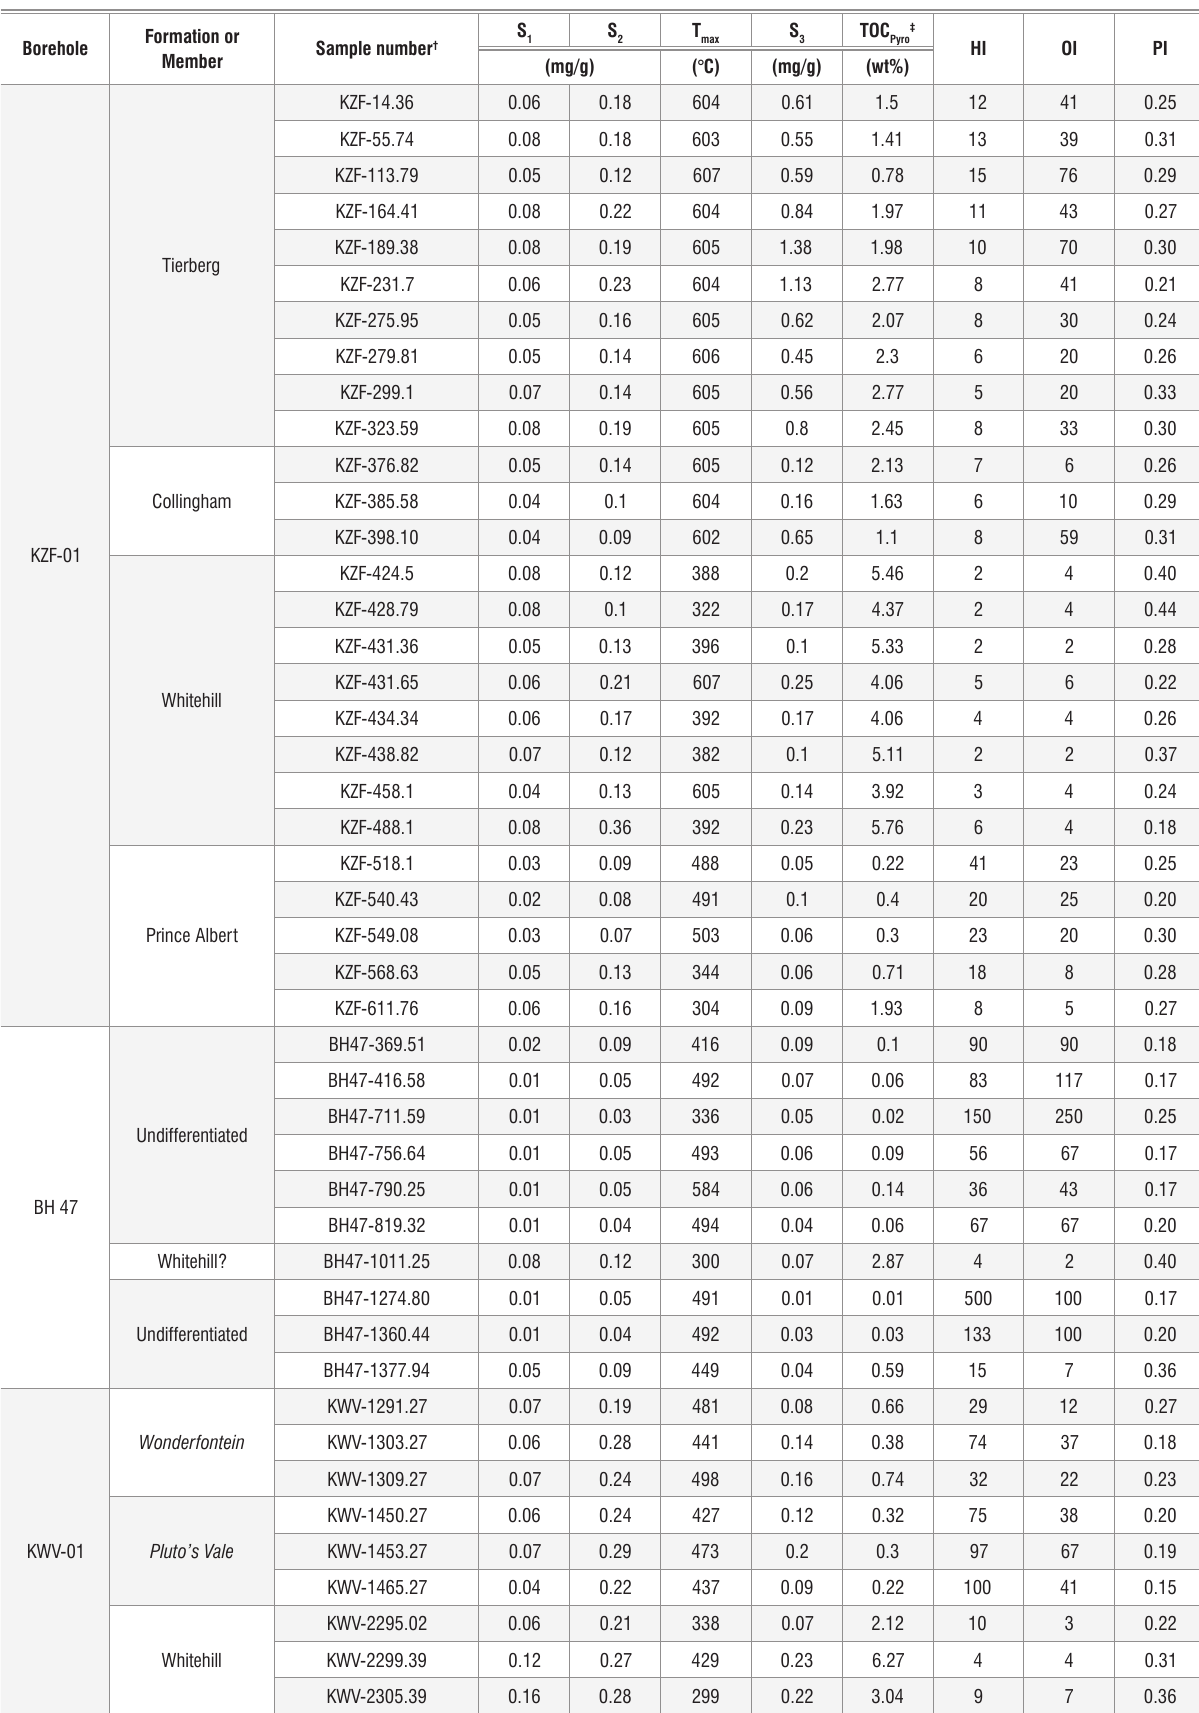
Table 5: Summary of Rock-Eval pyrolysis results Formation or Borehole Member